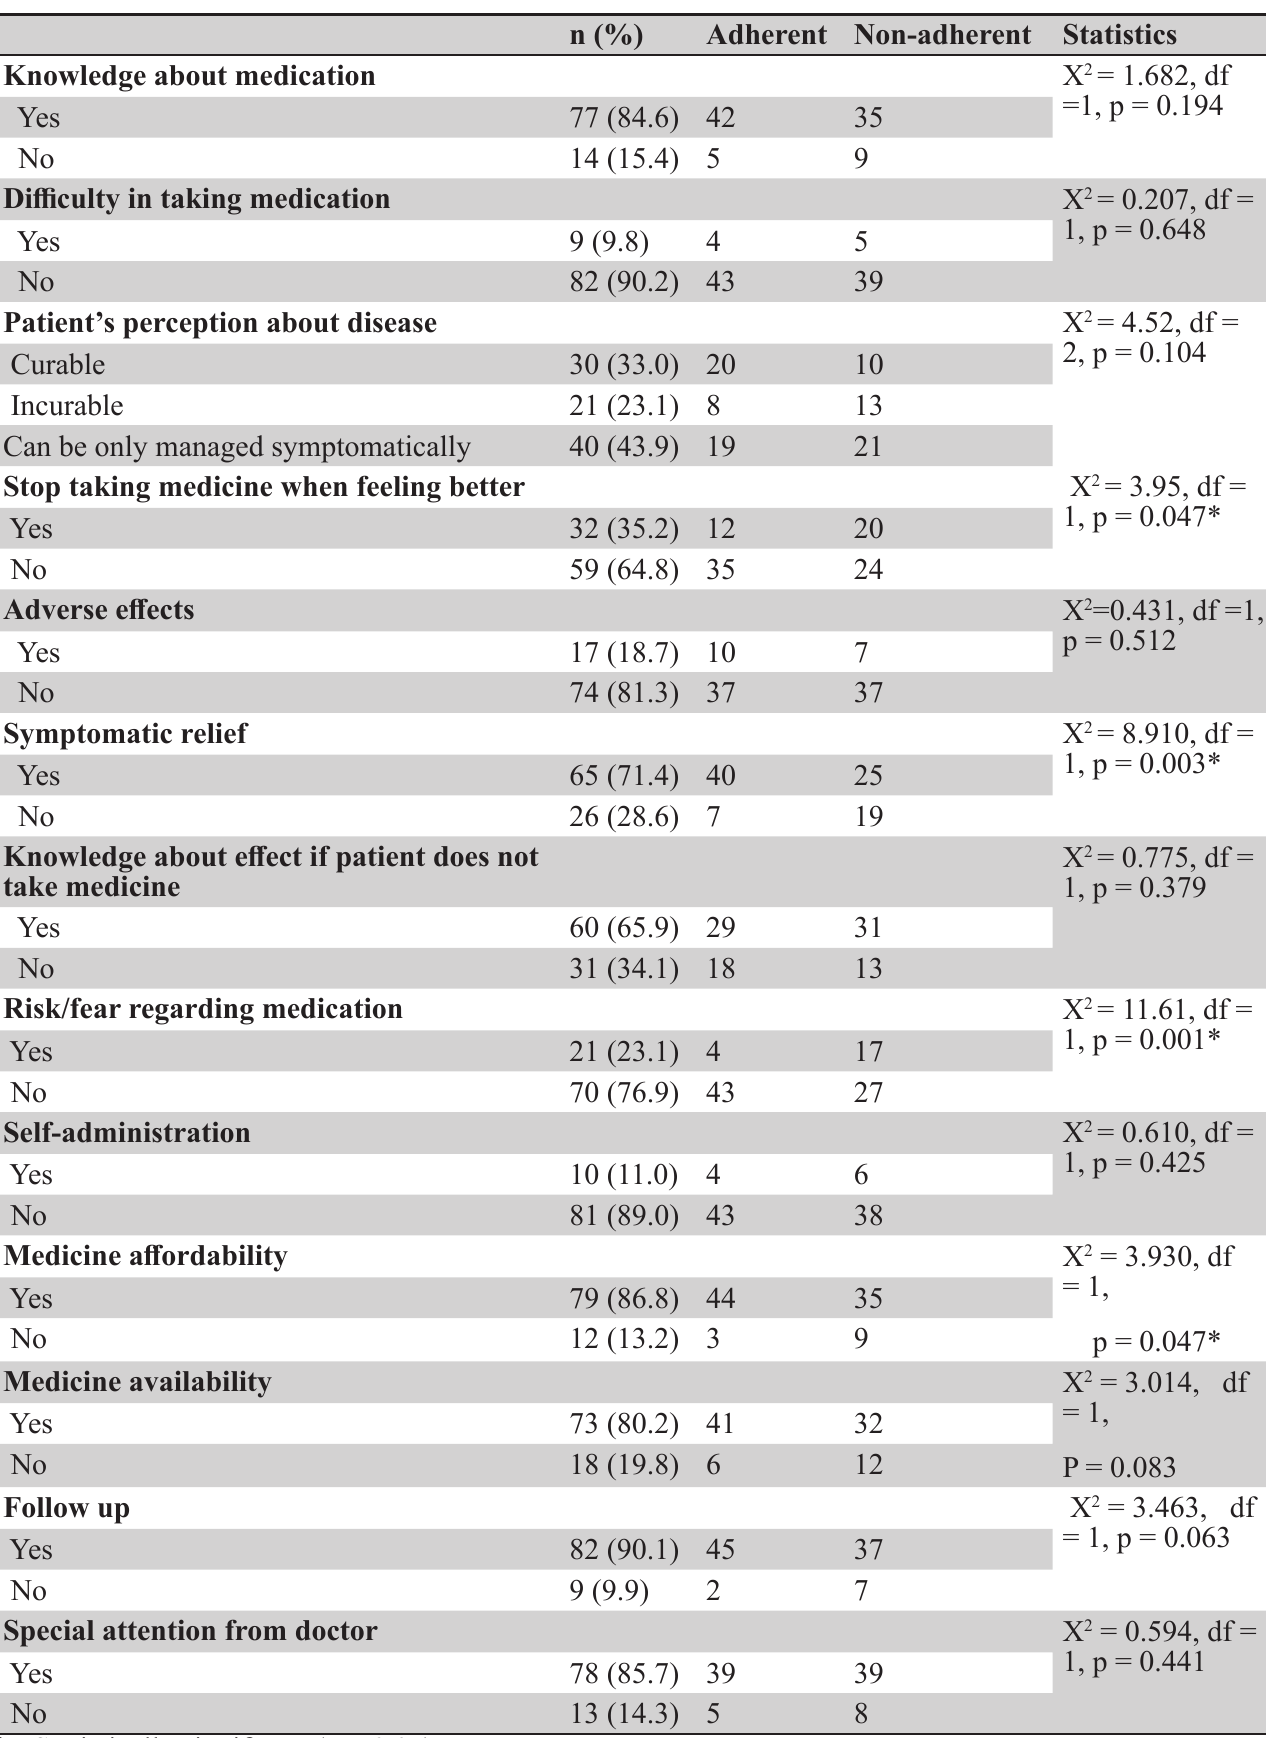
n (%) Adherent Non-adherent Statistics